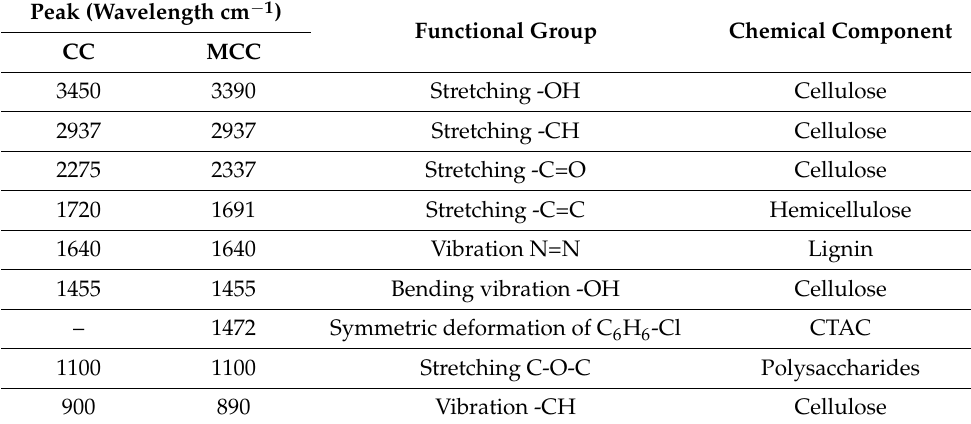
Table 3. Peak position and chemical group assignments in the CC and